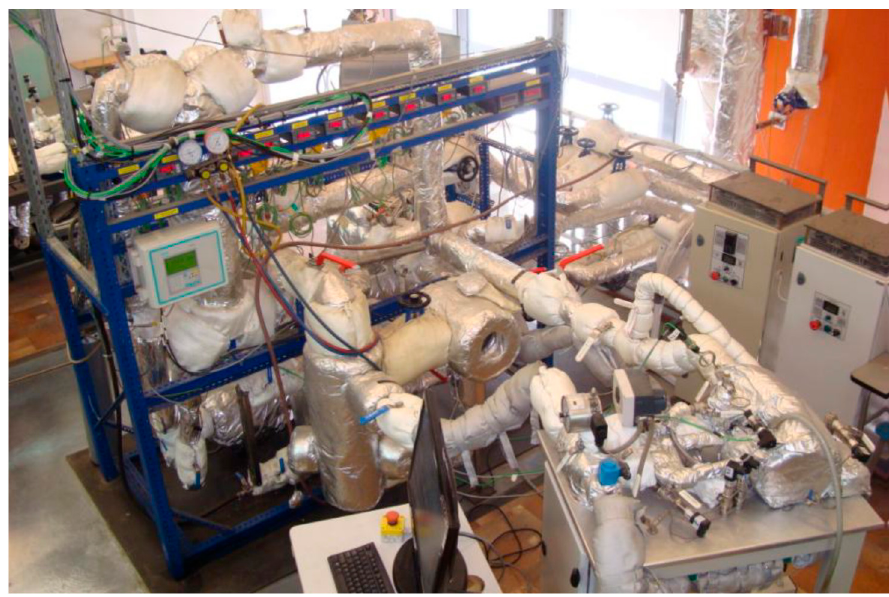
Figure 4. View of the experimental ORC power plant at IMP PAN.